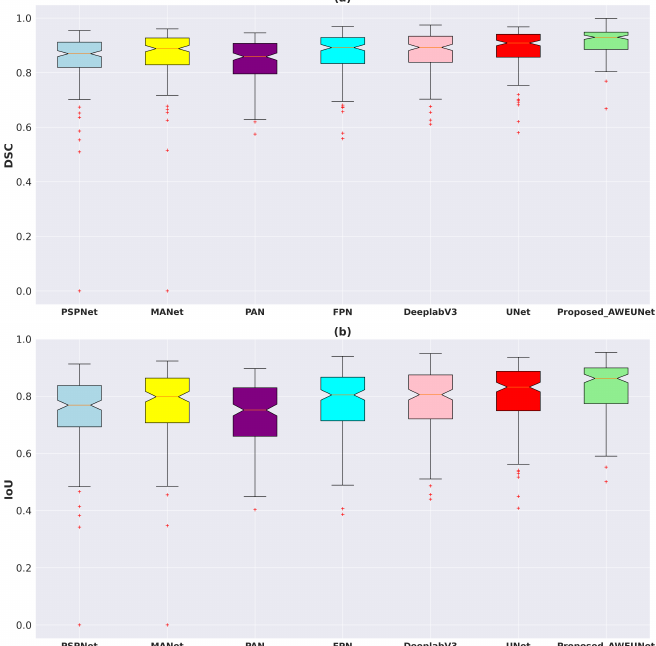
Figure 7. Boxplots of ( a ) Dice coefficient (DSC) and ( b ) intersection over union (IoU) scores for all test samples of the LUNA16 lung nodule segmentation dataset. Different boxes indicate the score ranges of several methods; the red line inside each box represents the median value, and all values outside the whiskers are considered outliers, which are marked with the (+) symbol.